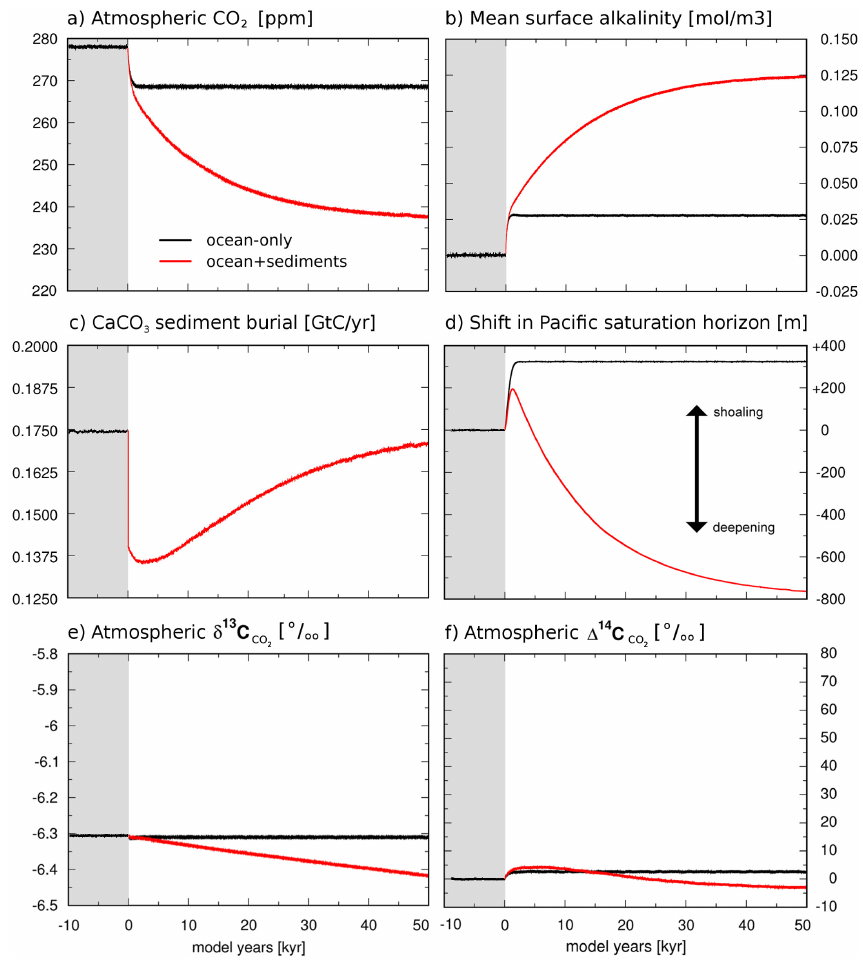
Fig. 3. Rain ratio reduction: Simulated response to a 20%-reduction in CaCO 3 export. (a) Atmospheric CO 2 , (b) mean surface alkalinity, (c) CaCO 3 sedimentation, (d) shift in Pacific CaCO 3 saturation horizon, (e) atmospheric δ 13 C CO atmospheric δ 13 C CO (Fig. 3e, black line) and 1 14 C CO 2 raised by a modest 3 ‰ (Fig. 3f, black